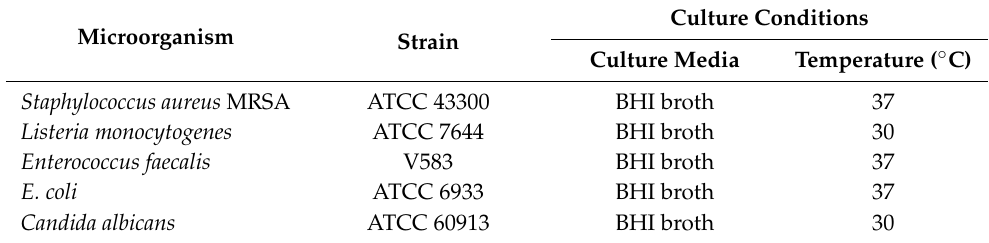
Table 1. Microorganisms and their culture conditions.